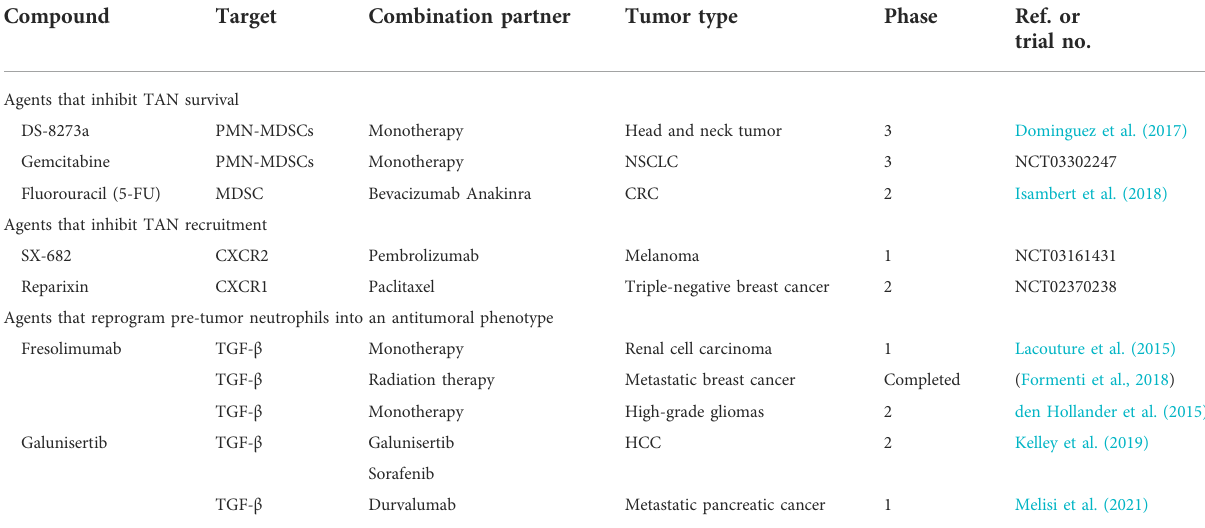
TABLE 2 Clinical trials of agents targeting